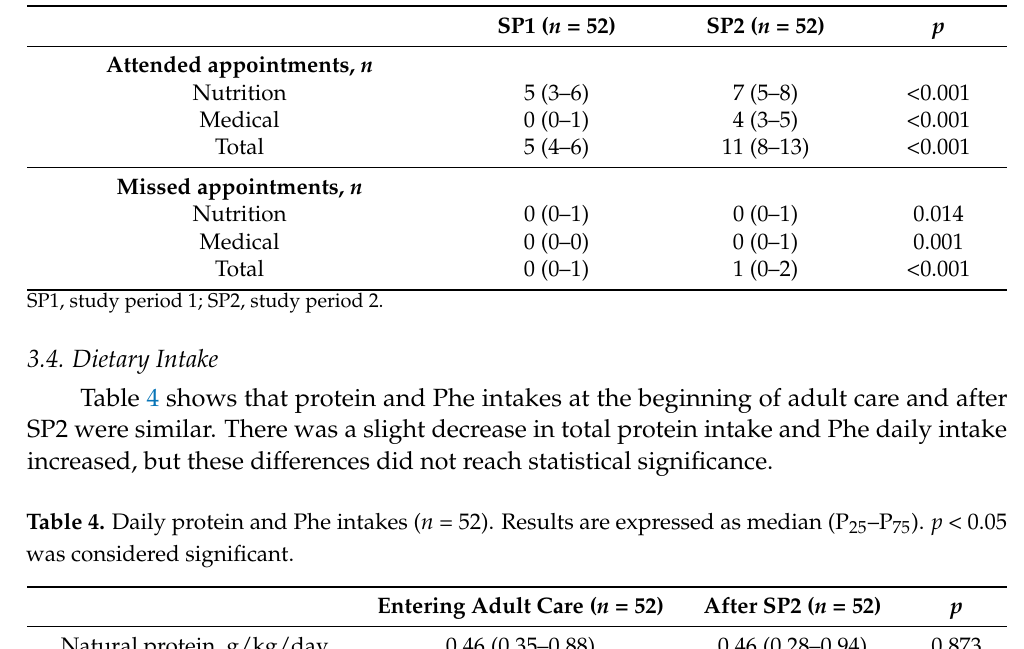
Table 3. Frequency of clinic visits in SP1 and SP2 ( n = 52). Results are expressed as median (P 25 –P 75 ). p < 0.05 was considered significant.